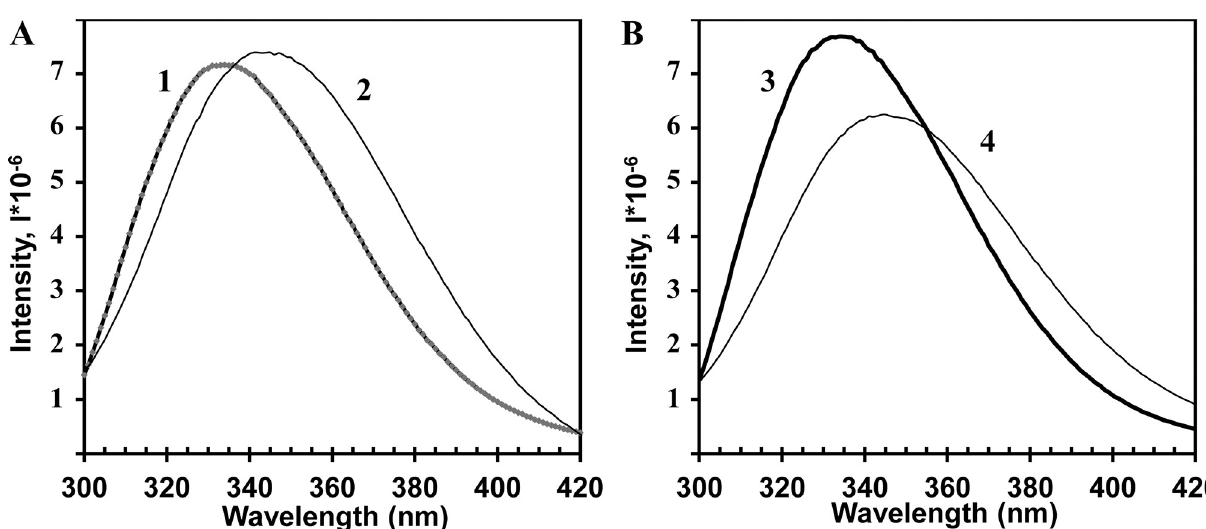
Fig 5. Intrinsic fluorescence spectra of A) AltMV VLPs (1) and SP VLP (2); B) AltMV virions (3) and SP V (4). The spectra were recorded at 25˚C. The solution details are specified in Materials and Methods. Three repeated experiments were carried out with similar results. The spectra presented in the figure are the visualization of one